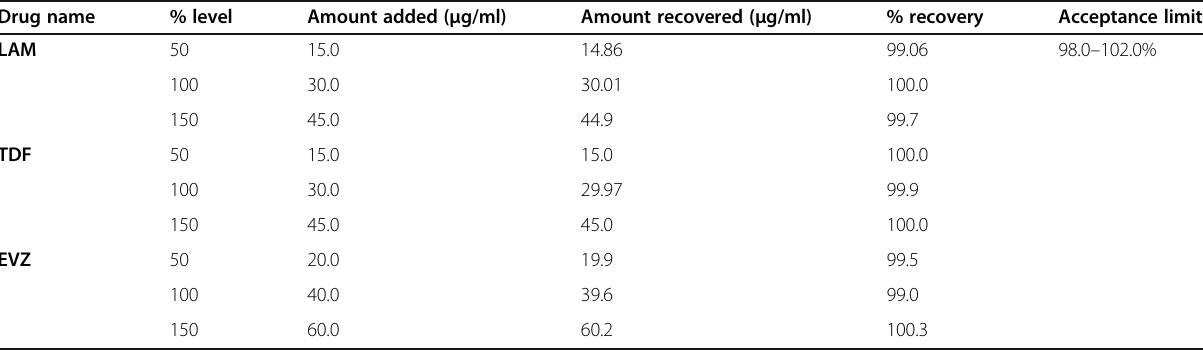
Table 4 Results of percentage